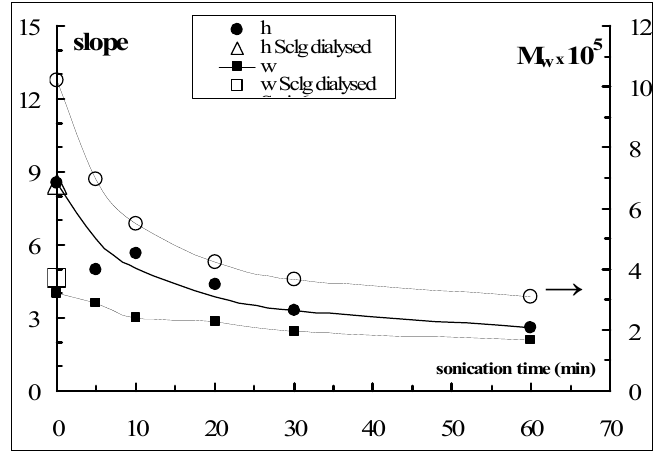
Figure 10. Slopes of the fickian linear trends for the water uptake and height increase (left) together with the molecular weight dependence on the sonication time